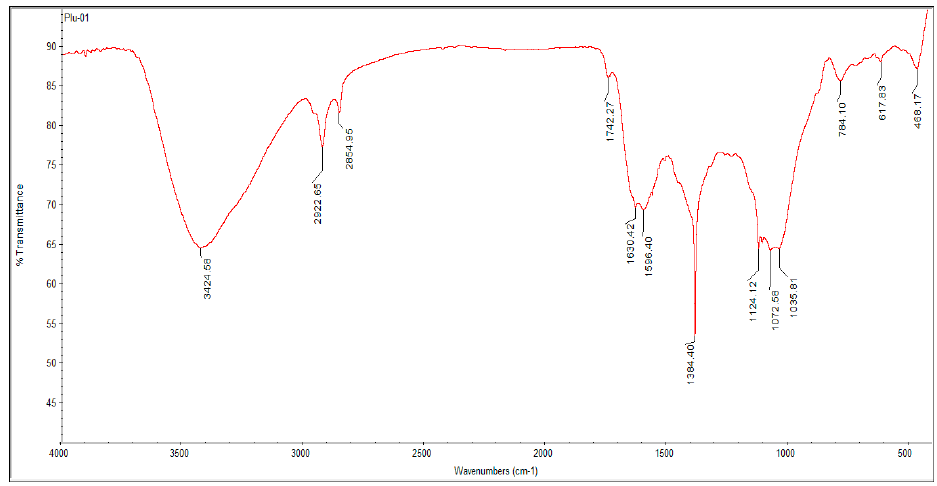
Figure 4. FTIR analysis of synthesized P-AgNPs from P. alba leaf extract.